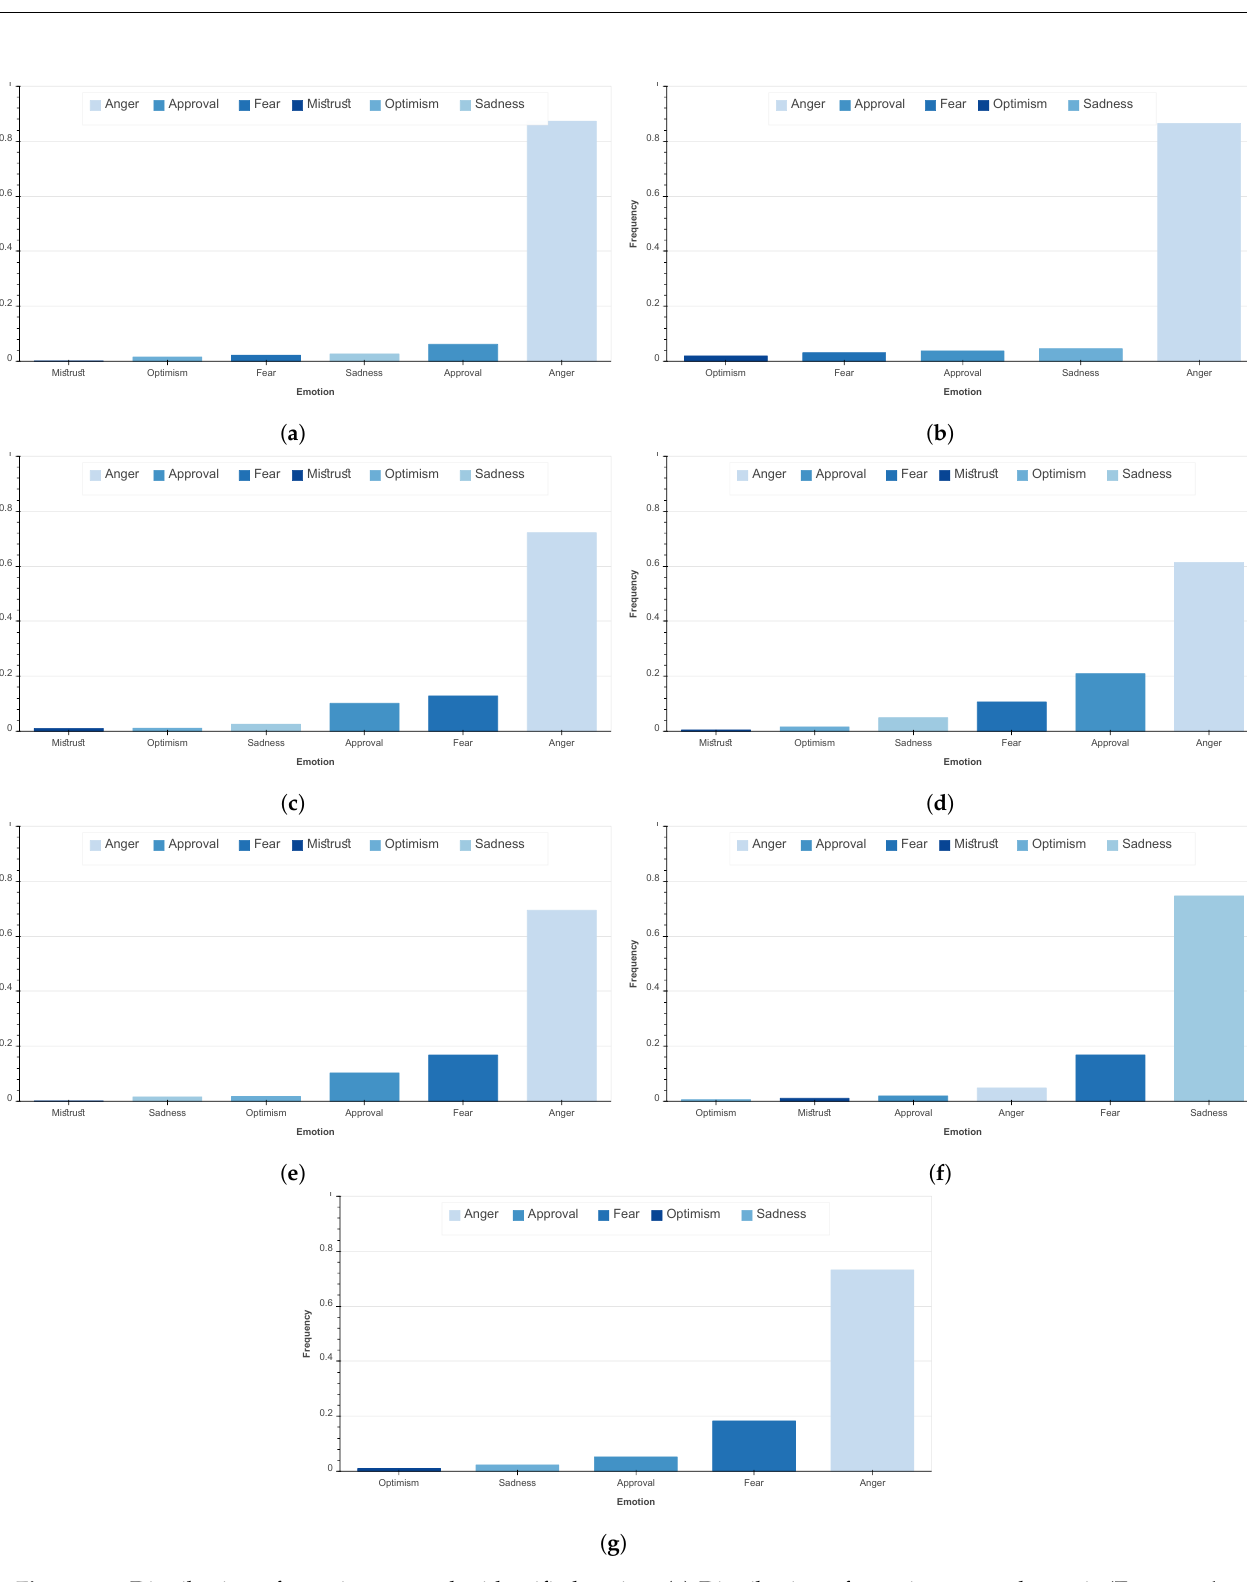
Figure 10. Distribution of emotions over the identified topics. ( a ) Distribution of emotions over the topic ‘Economy’. ( b ) Distribution of emotions over the topic ‘Education’. ( c ) Distribution of emotions over the topic ‘Health’. ( d ) Distribution of emotions over the topic ‘Government’. ( e ) Distribution of emotions over the topic ‘Social Life’. ( f ) Distribution of emotions over the topic ‘Statistics’. ( g ) Distribution of emotions over the topic ‘Sanitary